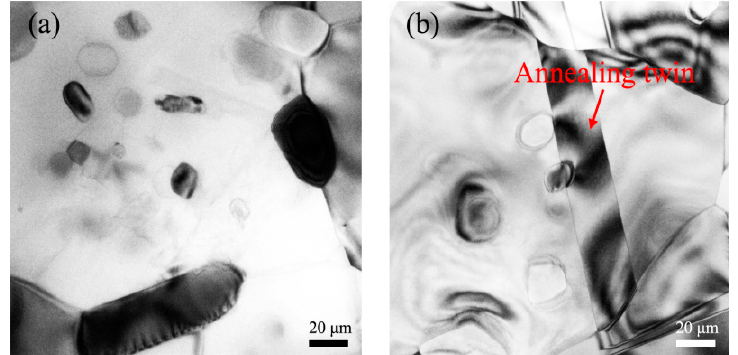
Figure 7. B2 phase images of various samples: ( a ) AR600 sample, ( b ) AR700 sample, ( c ) AR800 sample.